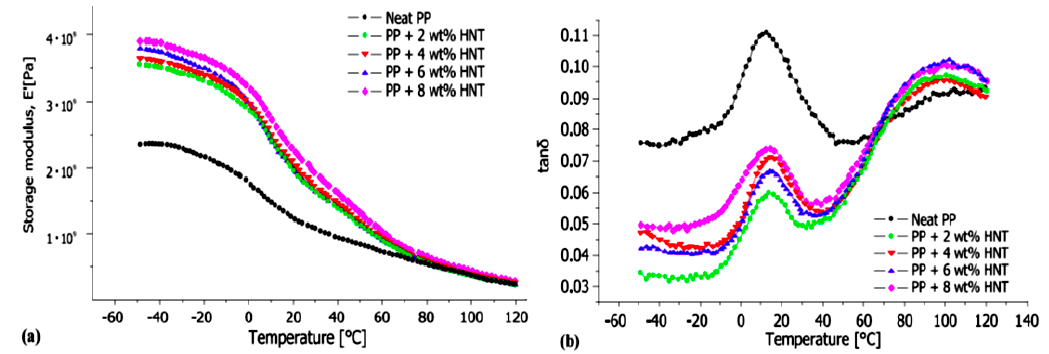
Figure 8. ( a , b ) TGA curves of neat PP, HNTs and PP/HNT nanocomposites in nitrogen [9].